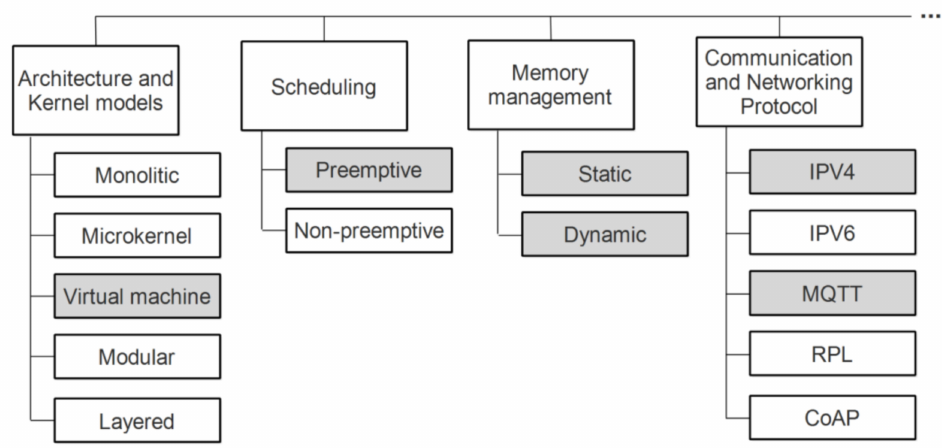
Figure 11. The adapted figure from [22] required in our implementation